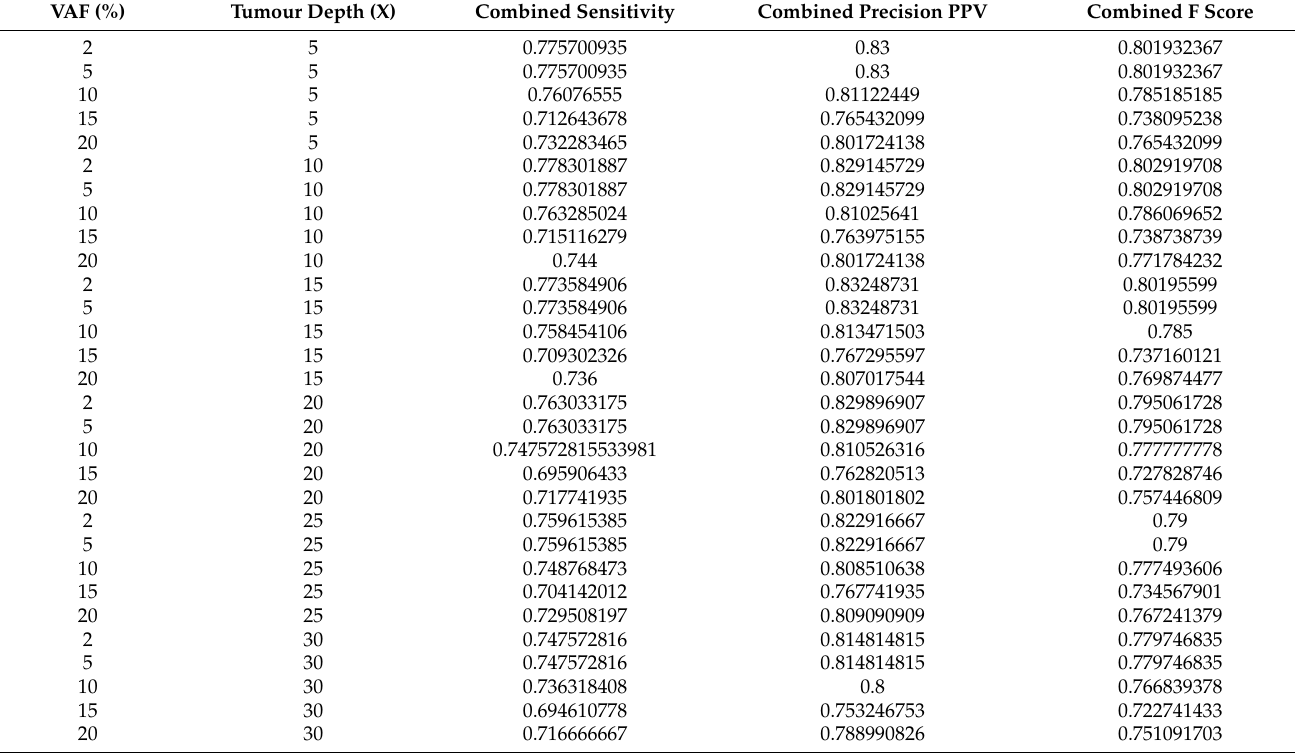
Table 2. Sensitivity, precision/positive predictive value (PPV), and F-Score for selected variant allele frequency (VAF) and tumour depth